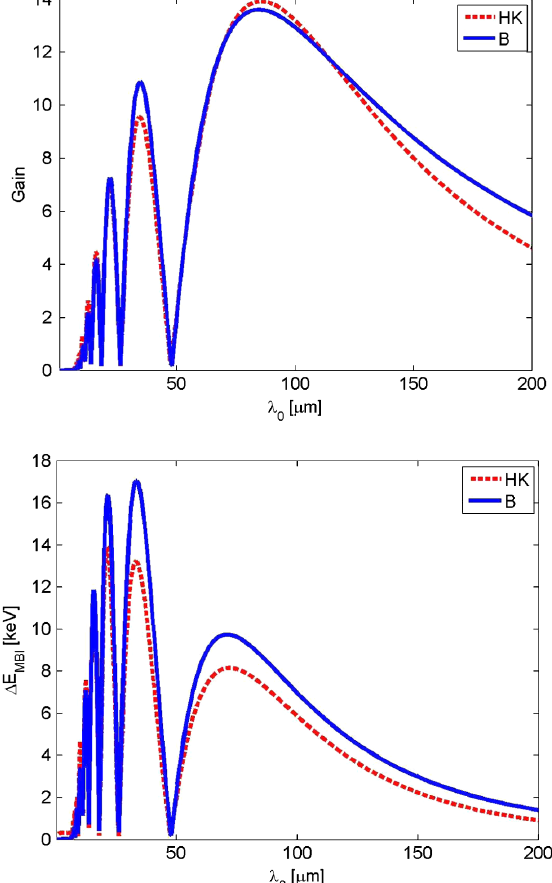
FIG. 2. Comparison of MBI gain (top) and energy modulation amplitude (bottom) at the end of the FERMI linac vs the initial density modulation wavelength. The two curves correspond to the separate predictions by the HK-model [22] (dashed line) and the B-model [23] (solid line). The laser heater is off.